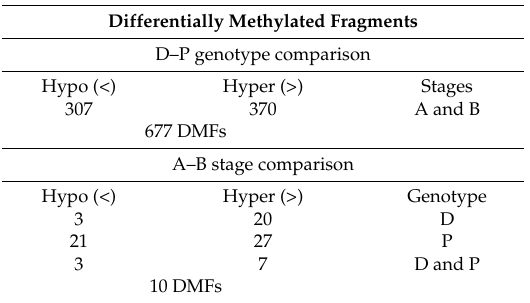
Table 1. Number of differentially methylated fragments (DMFs) detected by epi-Genotyping by Sequencing (epi-GBS) according to sample comparisons.